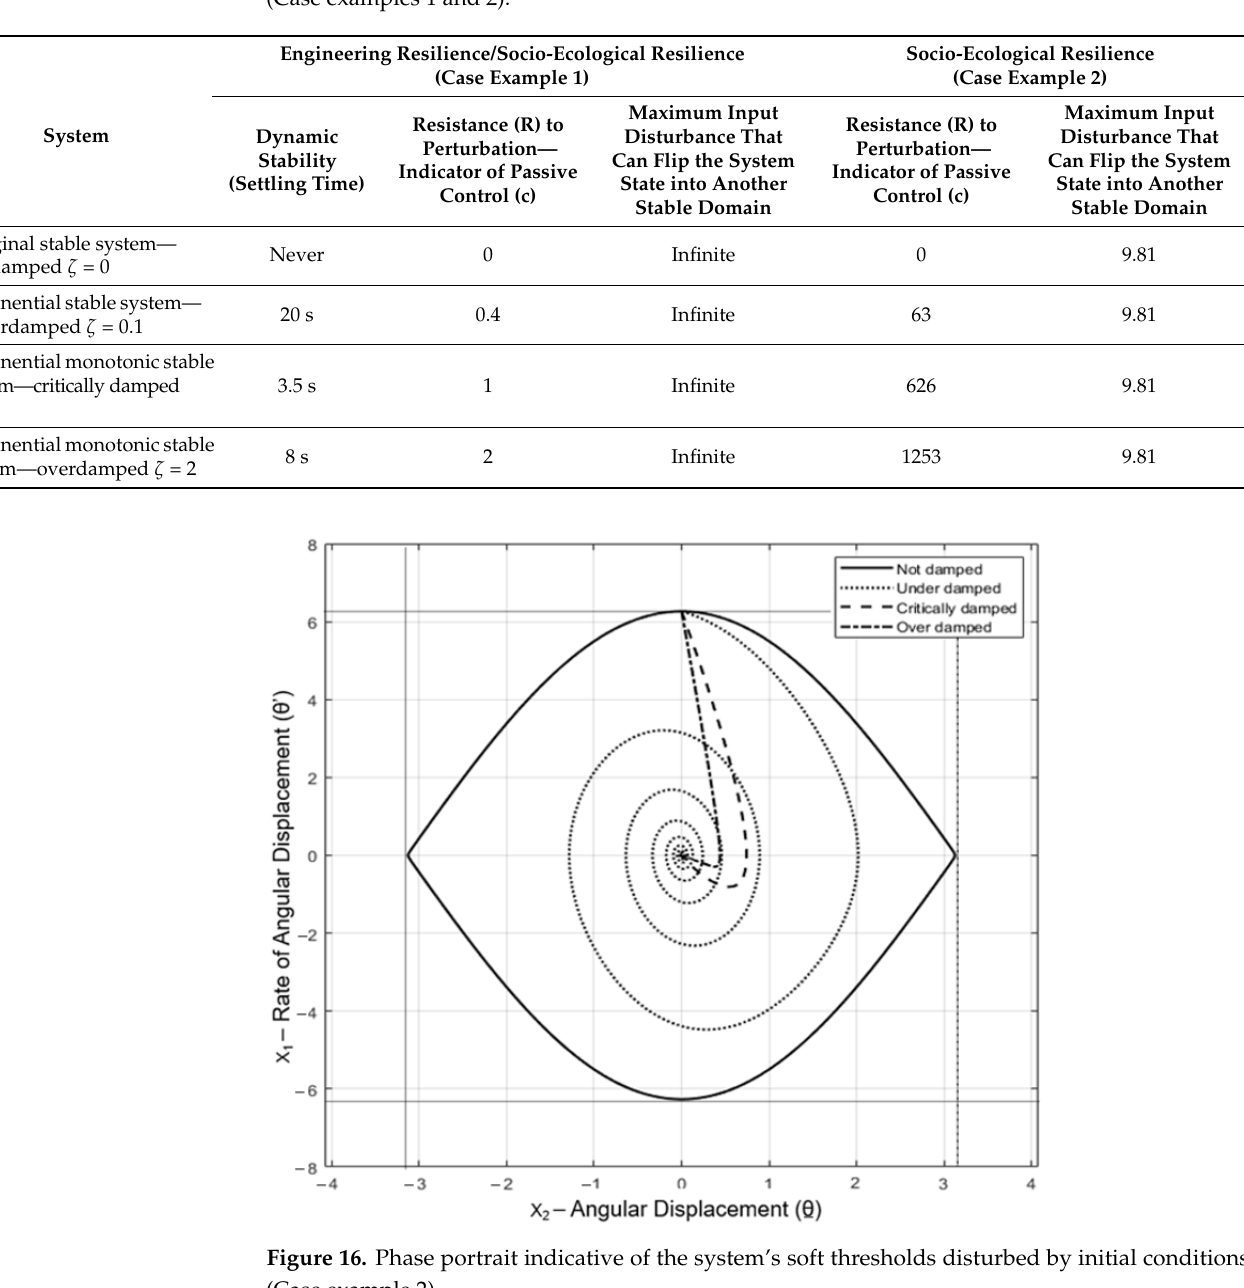
Table 7. Dynamic stability as a measure of engineering resilience for impulse input disturbance ( δ (t)) (Case examples 1 and 2).